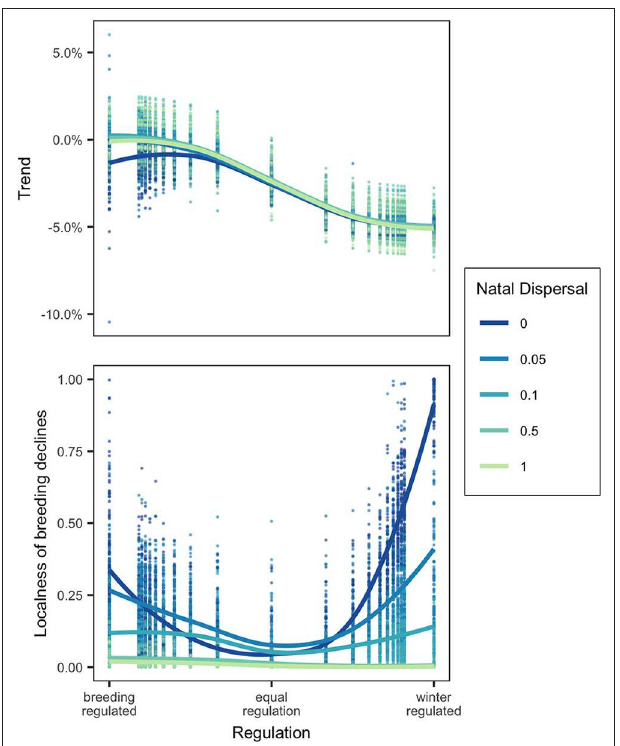
FIGURE 3 | Top panel shows the Trend (% decline in population) and bottom panel shows the localness (as defined in text) of declines following removal of occupied winter node for networks in which regulation where regulation (Equation 7) varies from 0 to 1 at five levels of natal dispersal, ND . Points show the results of model runs and trendlines are fitted locally weighted polynomial (loess)